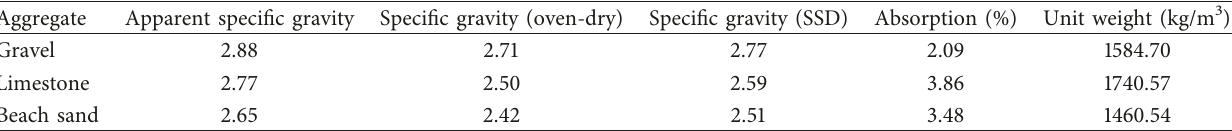
Table 1: Properties of the aggregates.